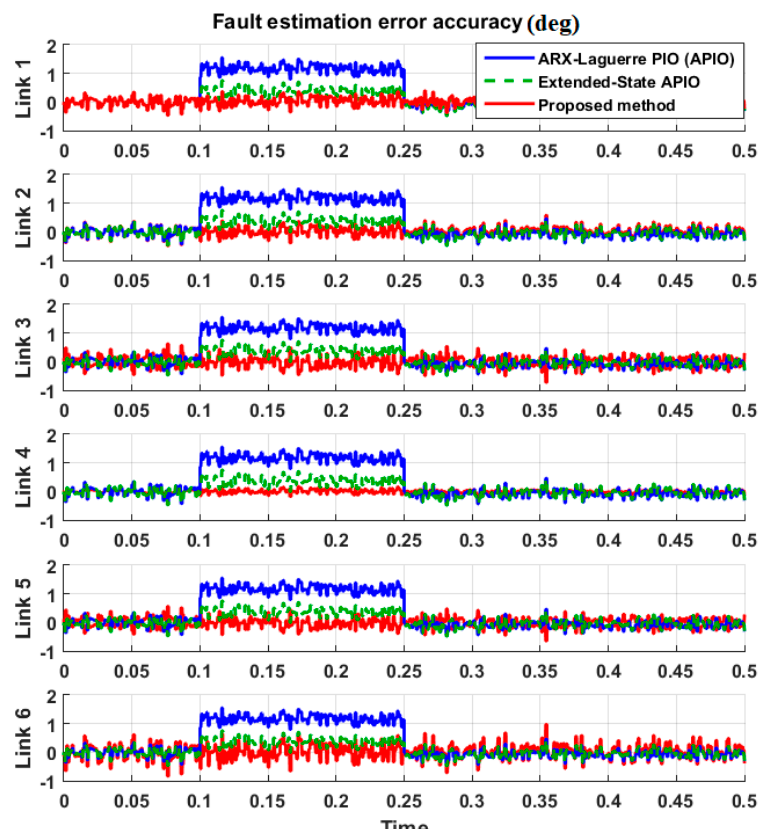
Figure 11. Fault estimation error based on ARX–Laguerre PI observer, sliding mode extended-state